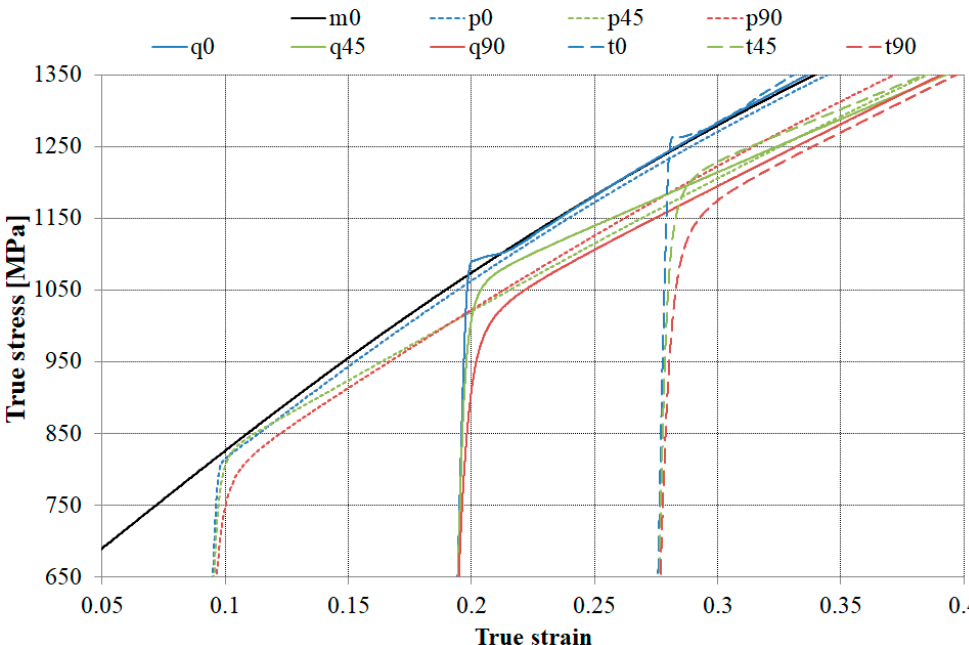
Figure 5. Zoomed version of Figure 4 where it is possible to compare the yield strengths for reloading cases with the curve obtained for a not pre-loaded sample (monotonic load).